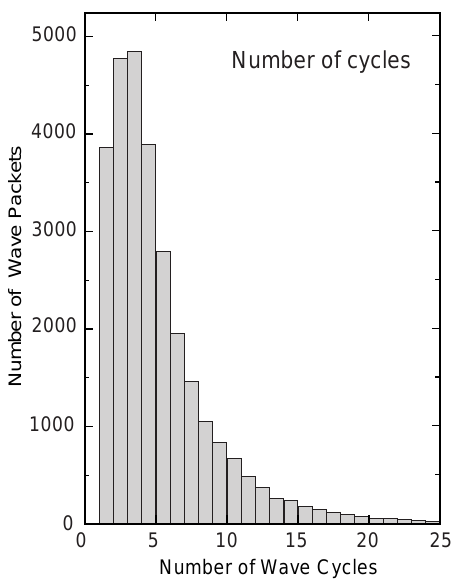
Fig. 6. Occurrence distribution of lion roar wave packet duration